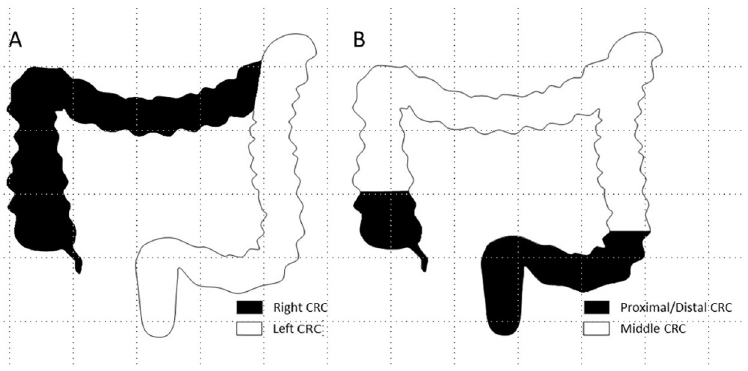
Fig 3. Illustration of anatomic distribution zones for CRC. A. Conventional laterality-based anatomic distribution (left and right) without significant association with prognosis; B. A newly proposed anatomic distribution (proximal/ distal and middle) with significant correlation with prognosis in African